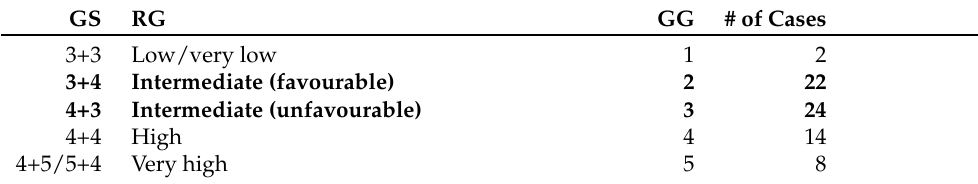
Table 2. Patients